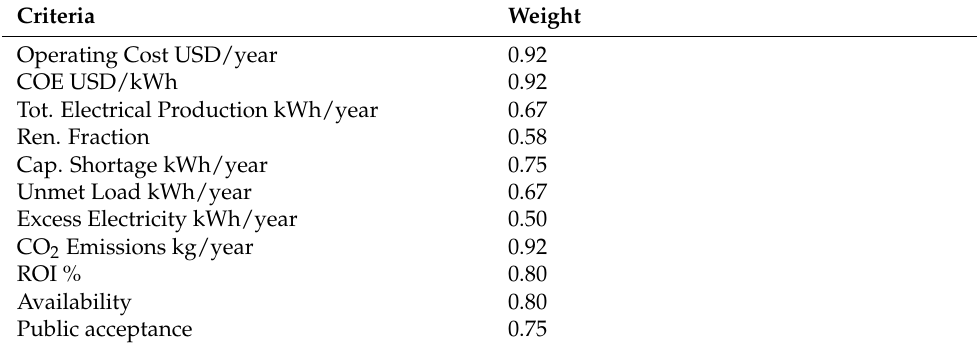
Table 8. Criteria weight ( W J